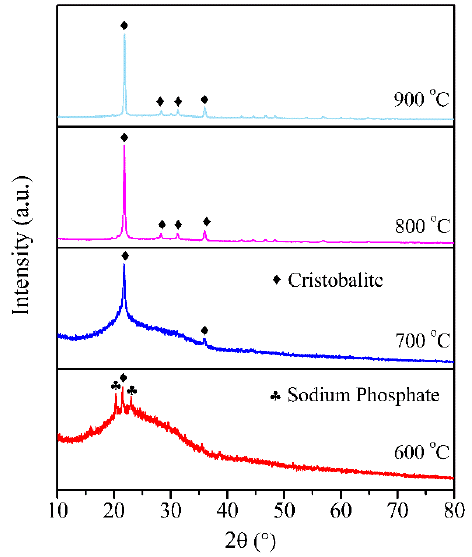
/ AF 10 fired at di